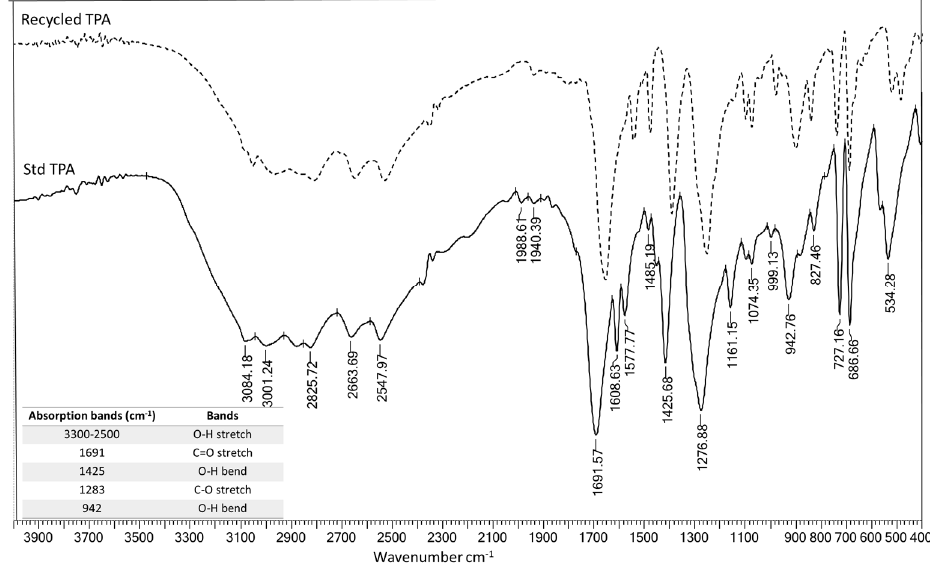
Figure 4. FTIR spectra of TPA standard and recycled TPA after hydrothermal degradation of colorless PET waste at the temperature of 350 °C and 120 min.